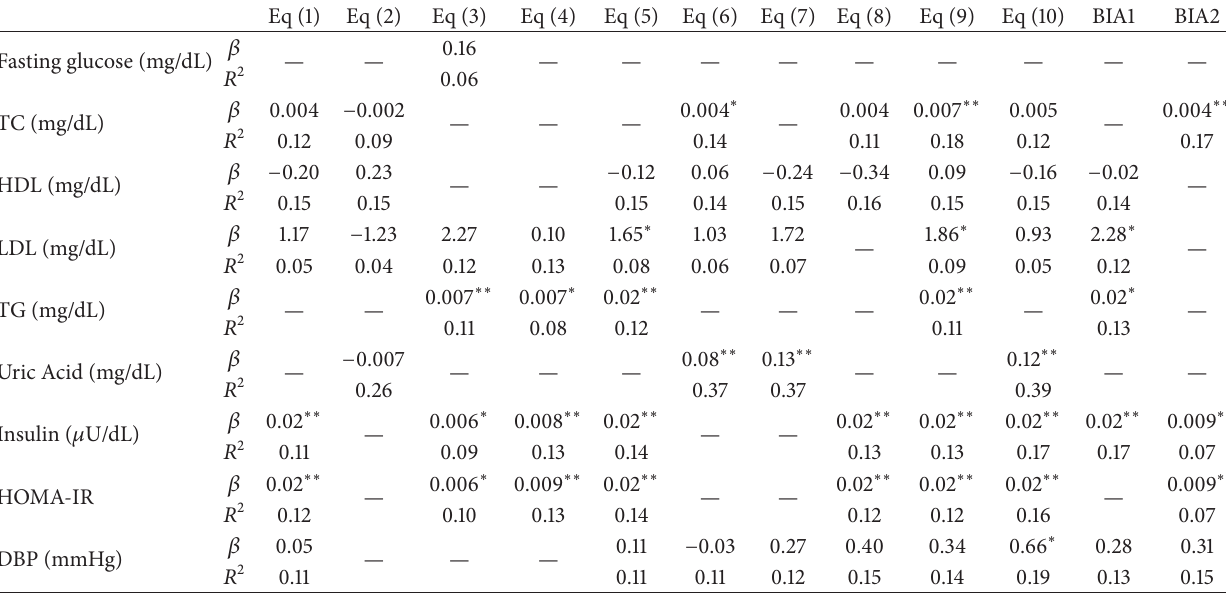
Table 6: Multiple linear regression coefficient ( 𝛽 ) and coefficient of determination ( 𝑅 2 ) of the relationship between percentage of body fat, adjusted for sex, and biochemical and clinical parameters in overweight adolescents (G2) (Vic¸osa, Minas Gerais, Brazil (2010)).